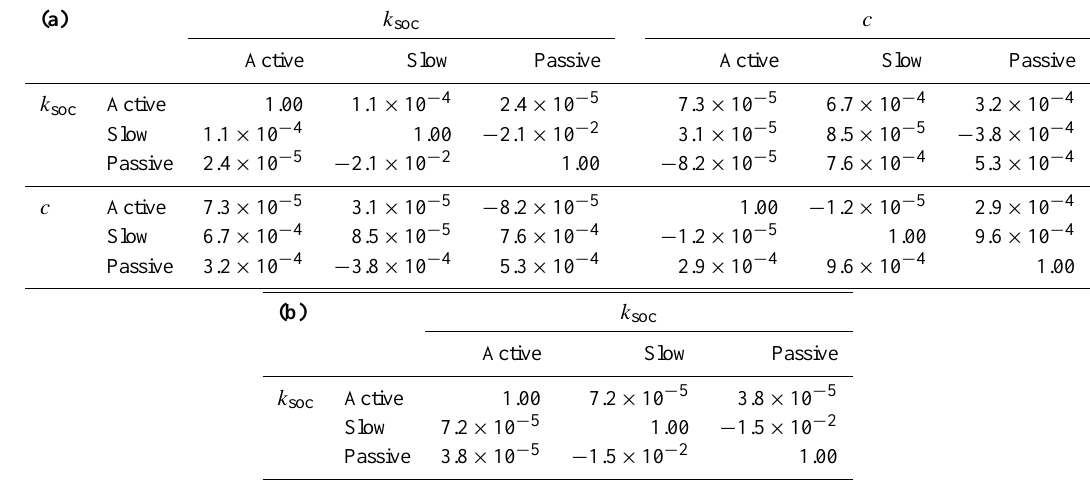
Table 4. Correlation between optimized parameters for (a) PRIM and (b) the ORCHIDEE soil module. (a) k soc c Active Slow